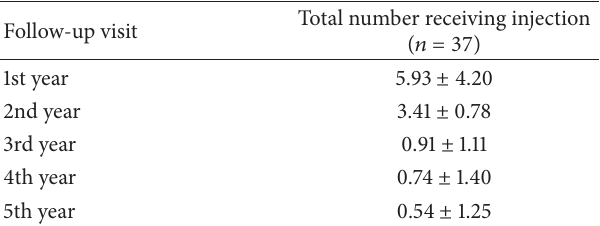
Table 2: The mean treatment times in 5